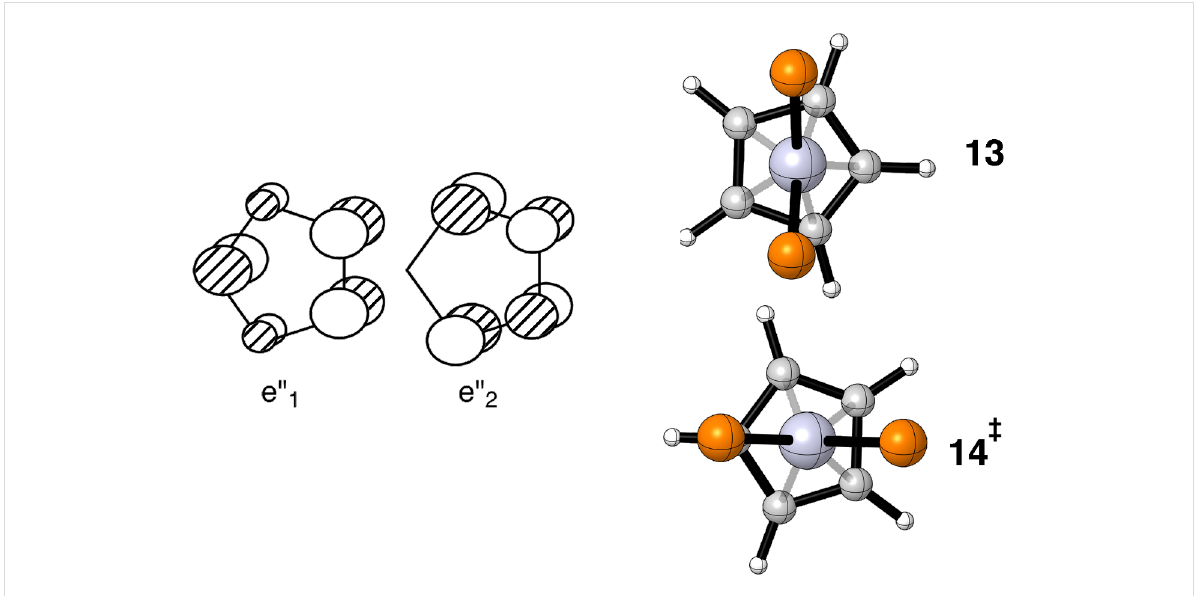
Figure 4: Two unoccupied MOs for Cp + are shown on the left side. The two stationary points for Cp–Pt(dpe) + are given by 13 and 14 . To conserve space the groups around the phosphorus atoms have been removed.